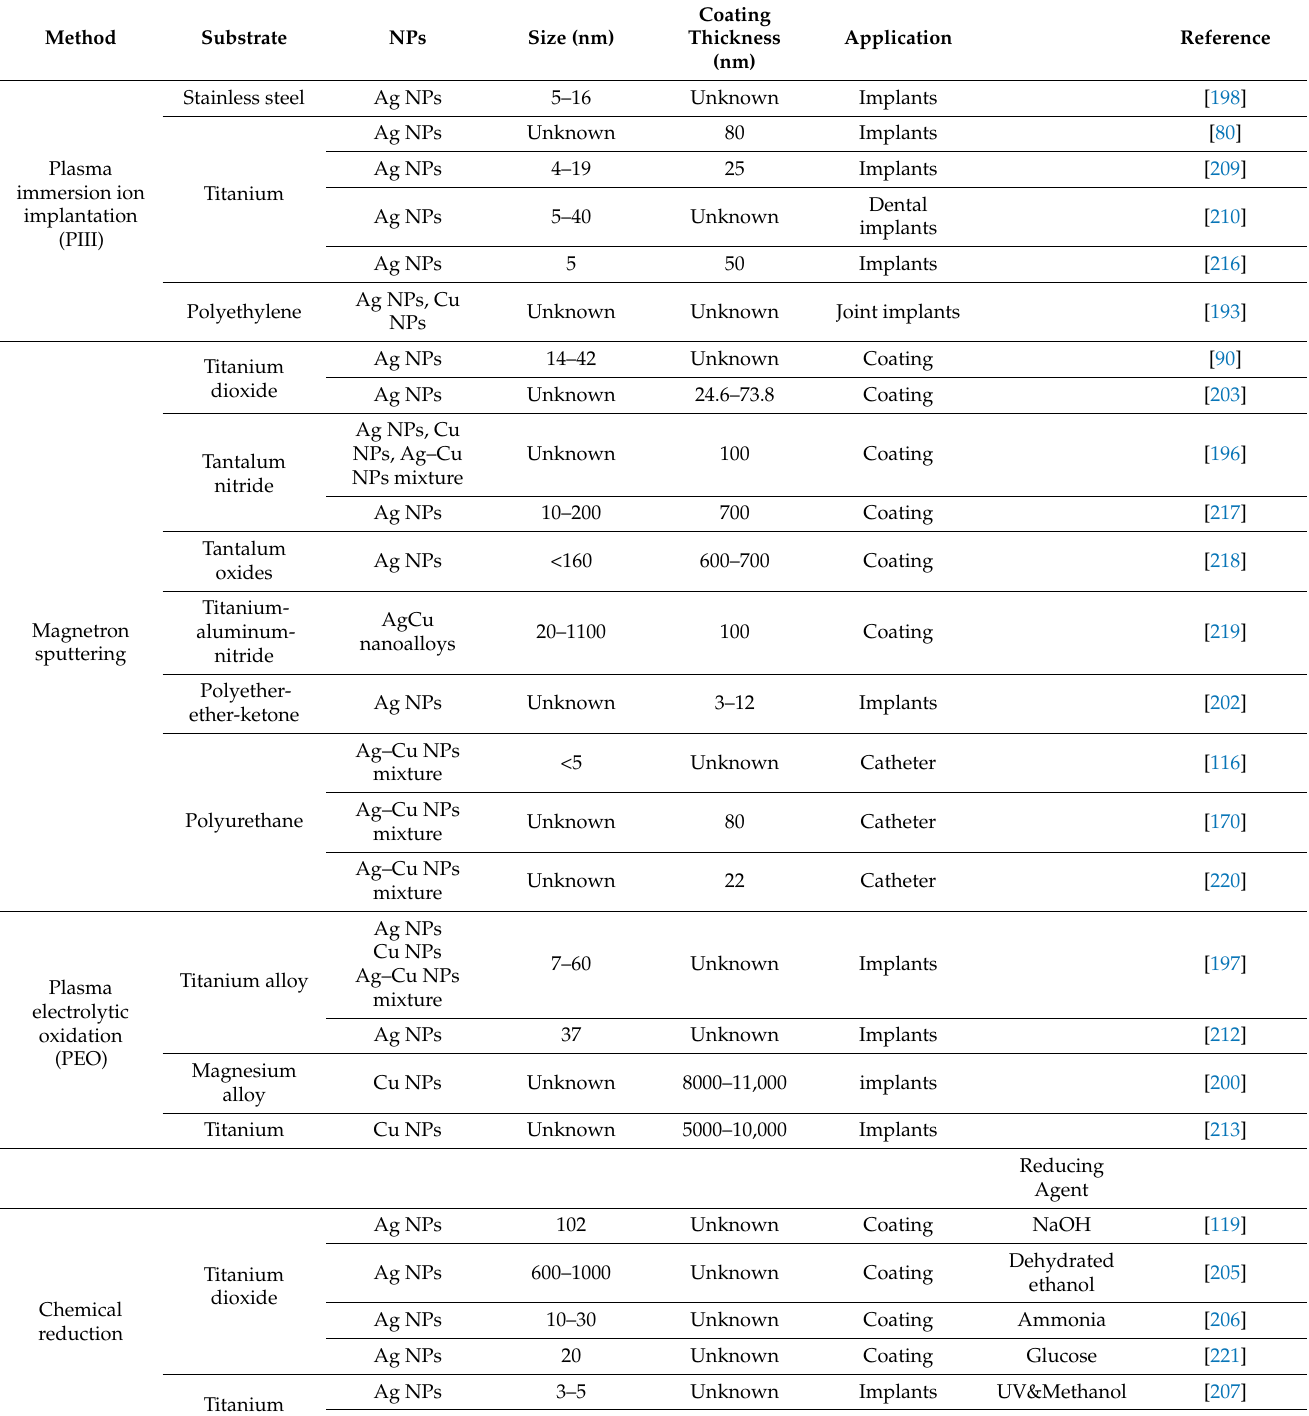
Table 1. Summary of implant surface modifications by Ag NPs, Cu NPs, Ag–Cu NPs mixture, and Ag–Cu nanoalloys.